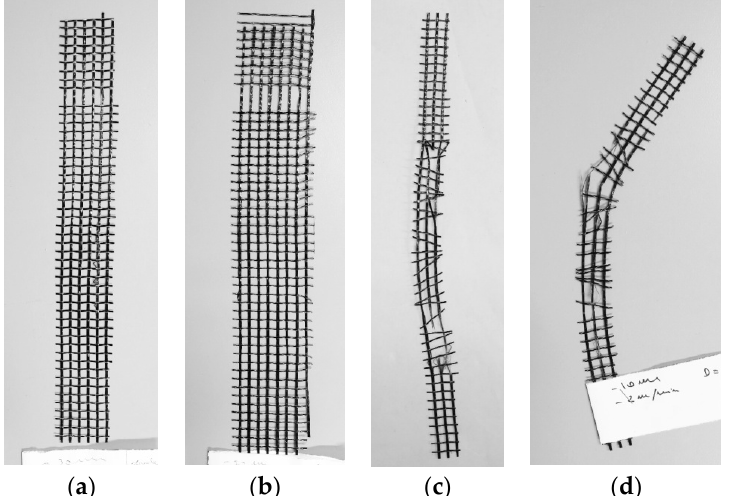
Figure 11. Failure modes of the basalt textile strips tested using leather in the gripping area: ( a ) specimen with dimensions of 33.5 × 200 mm, ( b ) specimen with dimensions of 47.5 × 200 mm, ( c ) specimen with dimensions of 13.5 × 200 mm and ( d ) specimen with dimensions of 13.5 × 150 mm.